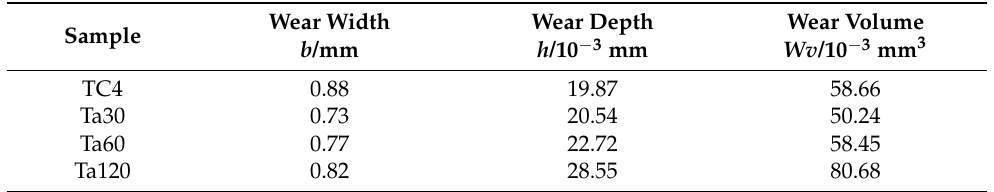
Figure 5. The wear scars’ profile curves ( a ) and the corresponding SEM image morphologies ( b ) of TC4 and Ta coatings prepared at 800 ◦ C with different alloying time. Table 1. Wear width, depth, and volume of Ta coatings after grinding against Si 3 N 4 balls with a load of 5 N for 20